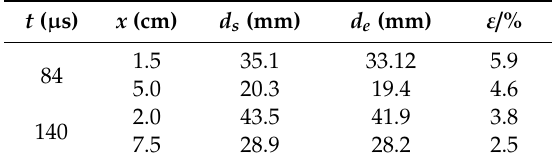
Table 3. Cavity diameter in the simulation results and test results.